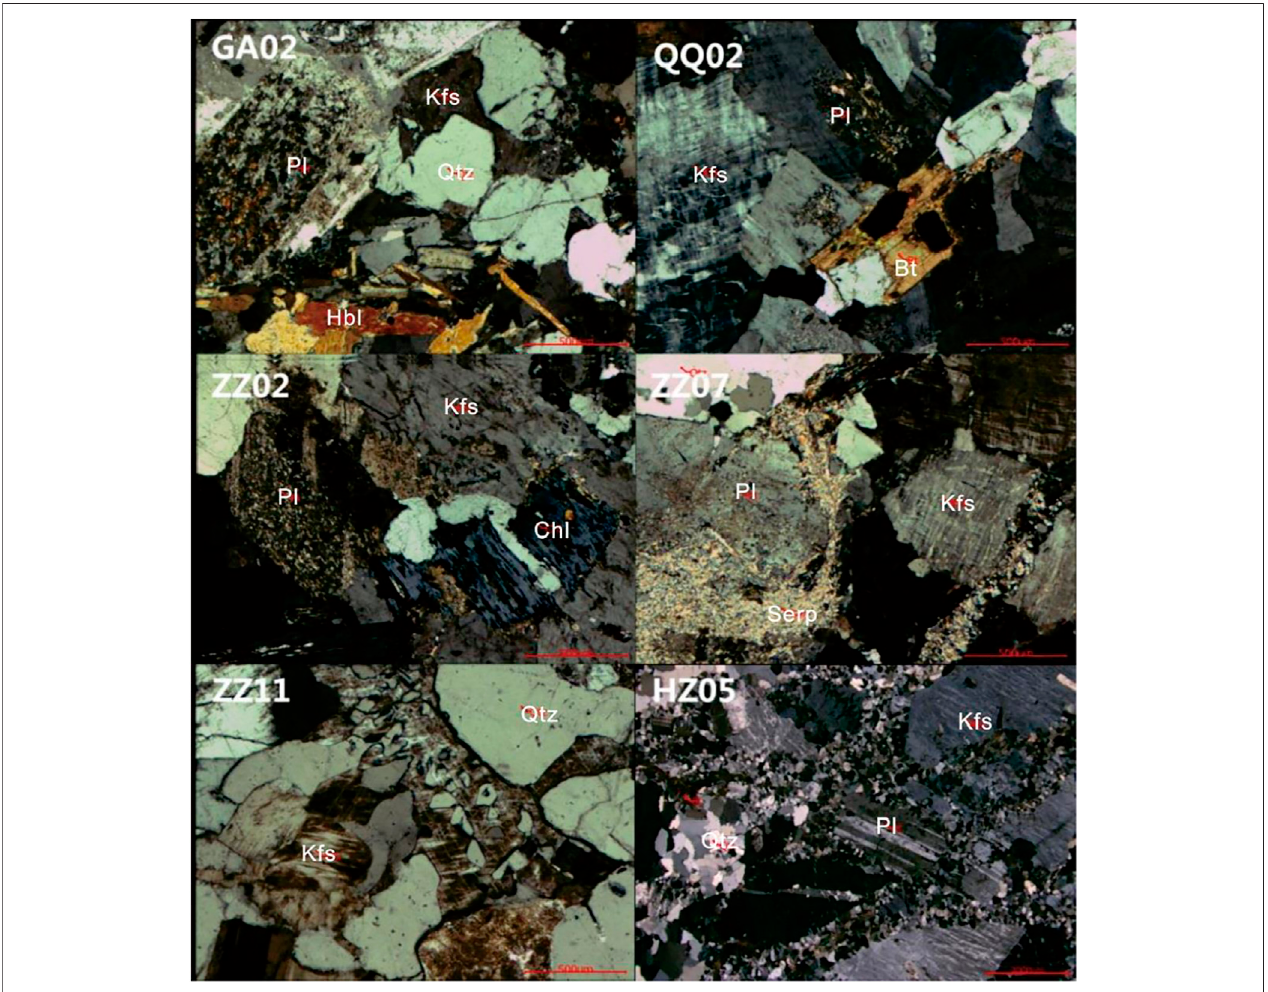
FIGURE 5 | Microphotographs showing mineral assemblage of representative granites. The abbreviations are: Pl-plagioclase, Qz-quartz, Bt-biotite, Kfs-K- feldspar, Amp-amphibole.